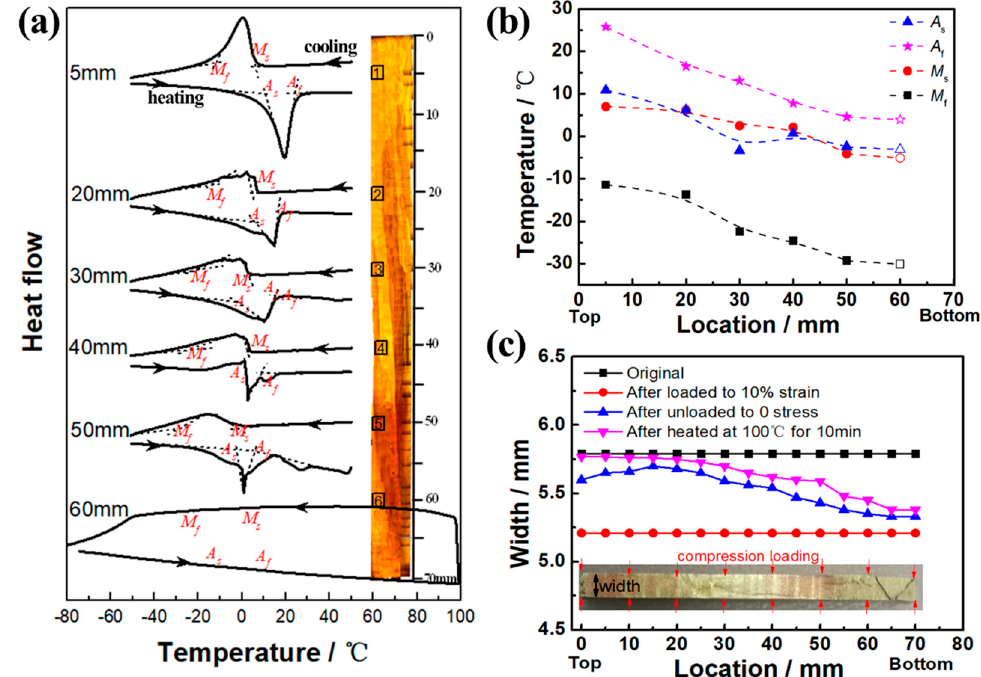
Figure 5. ( a ) Differential scanning calorimetry curves of different regions along the length of the #1 sample. ( b ) Changes of transformation temperatures with the location along the length of the #1 sample. ( c ) The original width, the width after being compression loaded, the width after being unloaded, and the width after being heated with the location along the length of the #2 sample.